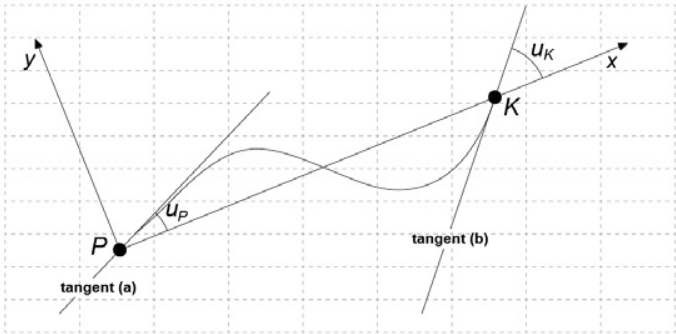
Figure 4. The first option: S -shaped transition curve connecting given points P and